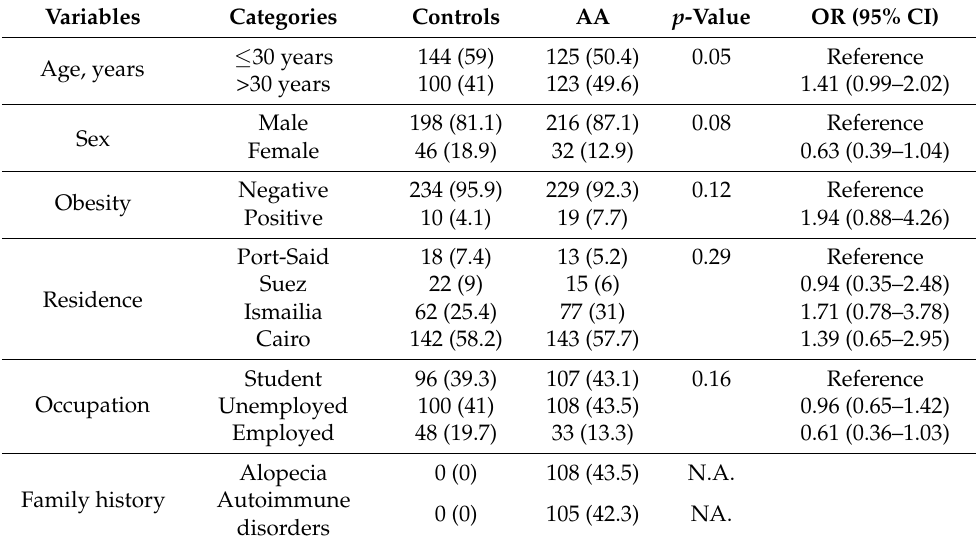
Table 1. Demographic characteristics of the study